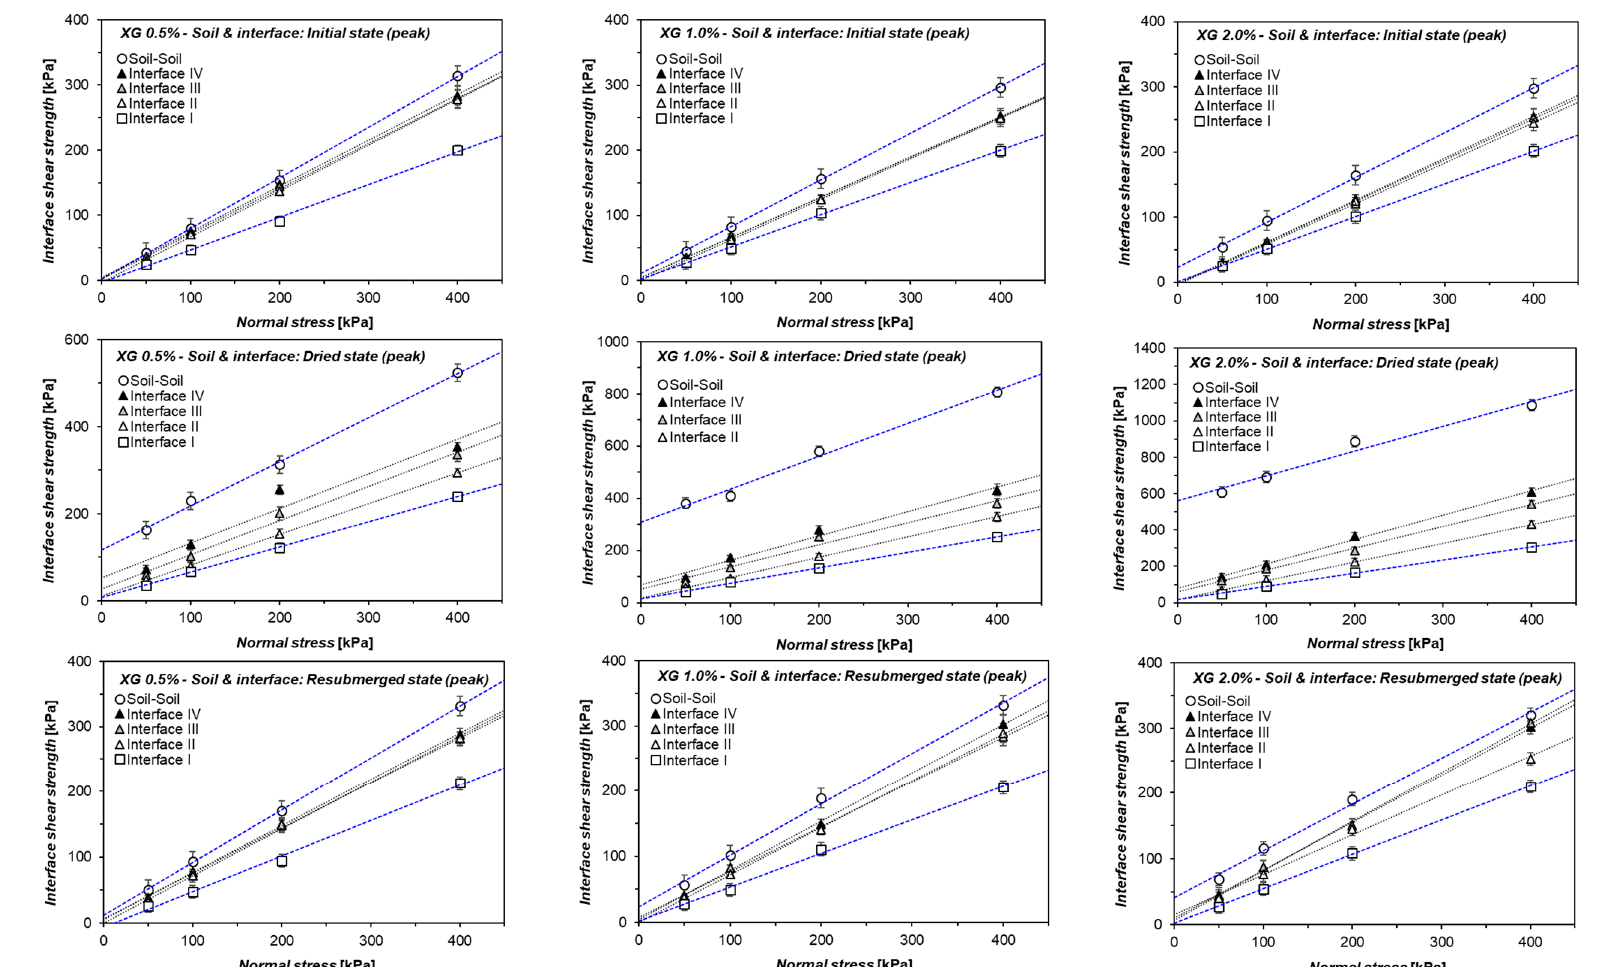
Figure 10. Peak strengths of xanthan gum-treated sand obtained from direct and interfacial shear tests.